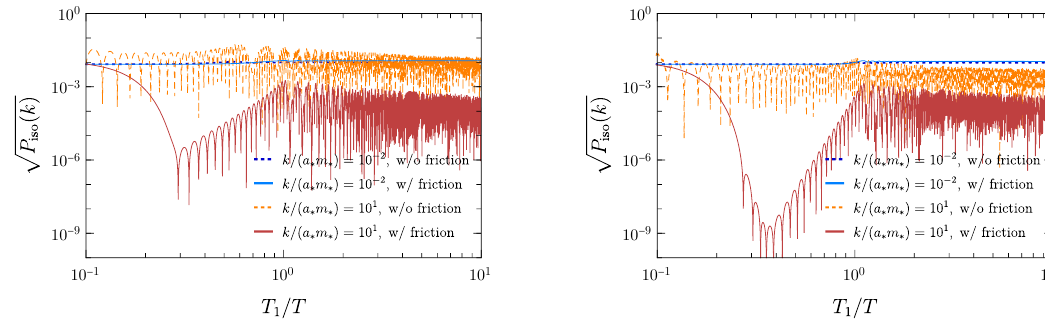
Figure 2 . ( Left ) Evolution of power spectrum of δ φ = δ ˆ ρ φ /ρ φ with a temperature-independent axion √ mass ( b = 0 ) for a large initial field perturbation ( δ ˆ φ/φ ) i = 10 2 2 . 1 × 10 − 9 . The solid (dashed) lines represent the evolution with (without) thermal friction. The low- k modes, i.e., k/ ( a ∗ m ∗ ) . 1 , maintain their initial amplitudes since m 2 ( k ) ' m 2 and the source terms are suppressed [40]. eff φ The high k -modes with thermal friction (red-solid line), i.e., k/ ( a ∗ m ∗ ) (cid:29) 1 , exhibit the initial decay state due to their large effective mass. The decay stage is followed by a mild enhancement √ √ P iso approaching the order of the curvature perturbation, δT/T ∼ P s . Here the parameter of set is chosen to explain the total dark matter abundance by the axion in the presence of thermal friction: f h ' 3 × 10 6 GeV , ξ = 10 − 7 , f = 10 16 GeV , m φ = 0 . 1 eV , g ∗ ( T 1 ) = 106 . 75 , θ i = 1 , and T 1 ' 2 TeV . ( Right ) Same as the left panel but for the QCD axion ( b ' 8 ). The qualitative